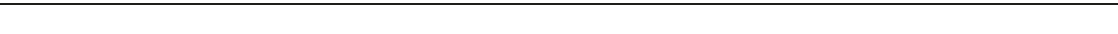
Fig. 4 3D structural modeling of PGAP4 demonstrating the unique split GT-A fold. a 3D structural model of PGAP4 lacking two TMDs (TM2 and TM3, corresponding to 262 – 308). The structure of PGAP4 Δ TM2, TM3 (pink) is superimposed to GT domain of the crystal structure of cellulose synthase (dark gray, PDB: 4P02A). Non-GT regions of cellulose synthase are in light gray. b The structural model of PGAP4 Δ TM2, TM3 exhibited split GT-A fold. Pink region, a region N-terminal to TM2; blue region, a region C-terminal to TM3; arrow, the joint after removal of two TMDs. c 3D structural model of PGAP4 with disul fi de bridges and three TMDs displayed in ribbon model. PGAP4 Δ N ( Δ 1 – 19) is shown. Cysteine residues are displayed with sticks. d Enlarged view of superimposed catalytic regions. (Upper) Schematic of PGAP4. Arrows, DXD-like motif and putative catalytic site. (Lower) Functionally important residues are shown with sticks. Pink: PGAP4 Δ TM2, TM3; cyan: cellulose synthase (PDB: 4P02A). Cellulose is displayed. e – g Analysis of DXD-like motif mutants of PGAP4 by western blotting ( e ), immuno fl uorescence imaging ( f ), and fl ow cytometry ( g ). pME-hPGAP4-3HA-bearing WT or mutant sequences was transiently transfected into 3BT5-PGAP4-KO cells and analyzed. e TfR, loading control. g Activities of PGAP4 mutants to restore GalNAc- modi fi ed GPI as assessed by staining with T5 mAb. (Upper) Dotted lines, background staining. (Lower) Quantitative data. Statistical analyses were done by unpaired Student ’ s t -test. *** p < 0.0005. h – j Analysis of catalytic mutant of PGAP4 by western blotting ( h ), immuno fl uorescence imaging ( i ), and fl ow cytometry ( j ). pME-hPGAP4-3HA-bearing WT or D363A sequence was transiently transfected into 3BT5-PGAP4-KO cells. h GAPDH, loading control. i GPP130, the Golgi marker. Scale bars: 10 µ m. j Functional analysis of the catalytic site mutant. Cells were stained with T5 mAb. (Left) Dotted lines, background staining. (Right) Quantitative data. Statistical analyses were done by unpaired Student ’ s t -test. *** p < 0.0005. e , f , h , i Representative data from two independent experiments. g , j Mean fl uorescence intensity ( ± SD) from three independent experiments ( n = 3). T5 staining of cells restored by WT PGAP4 was set as 100%. See also Supplementary Fig. 5, 6, 7 and